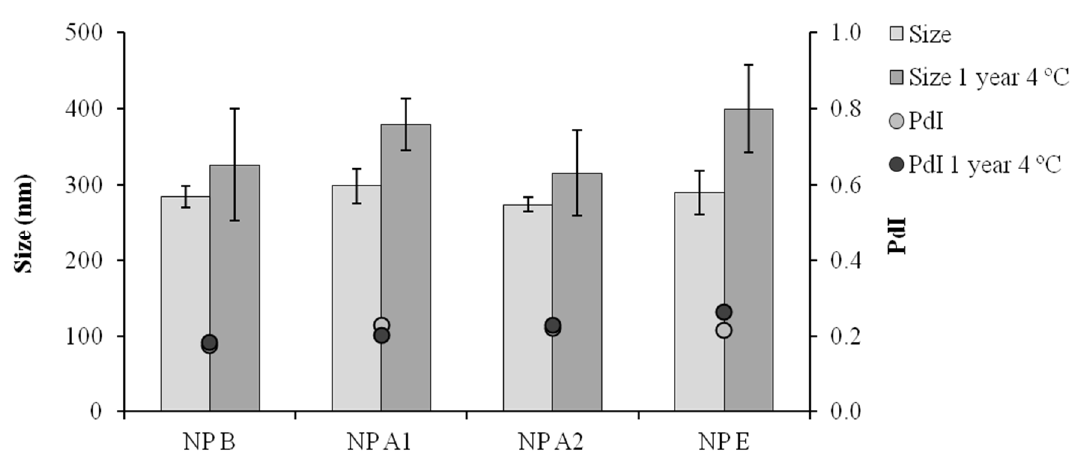
Figure 4. Particle size distribution (Size) and polydispersity index (PdI) after one